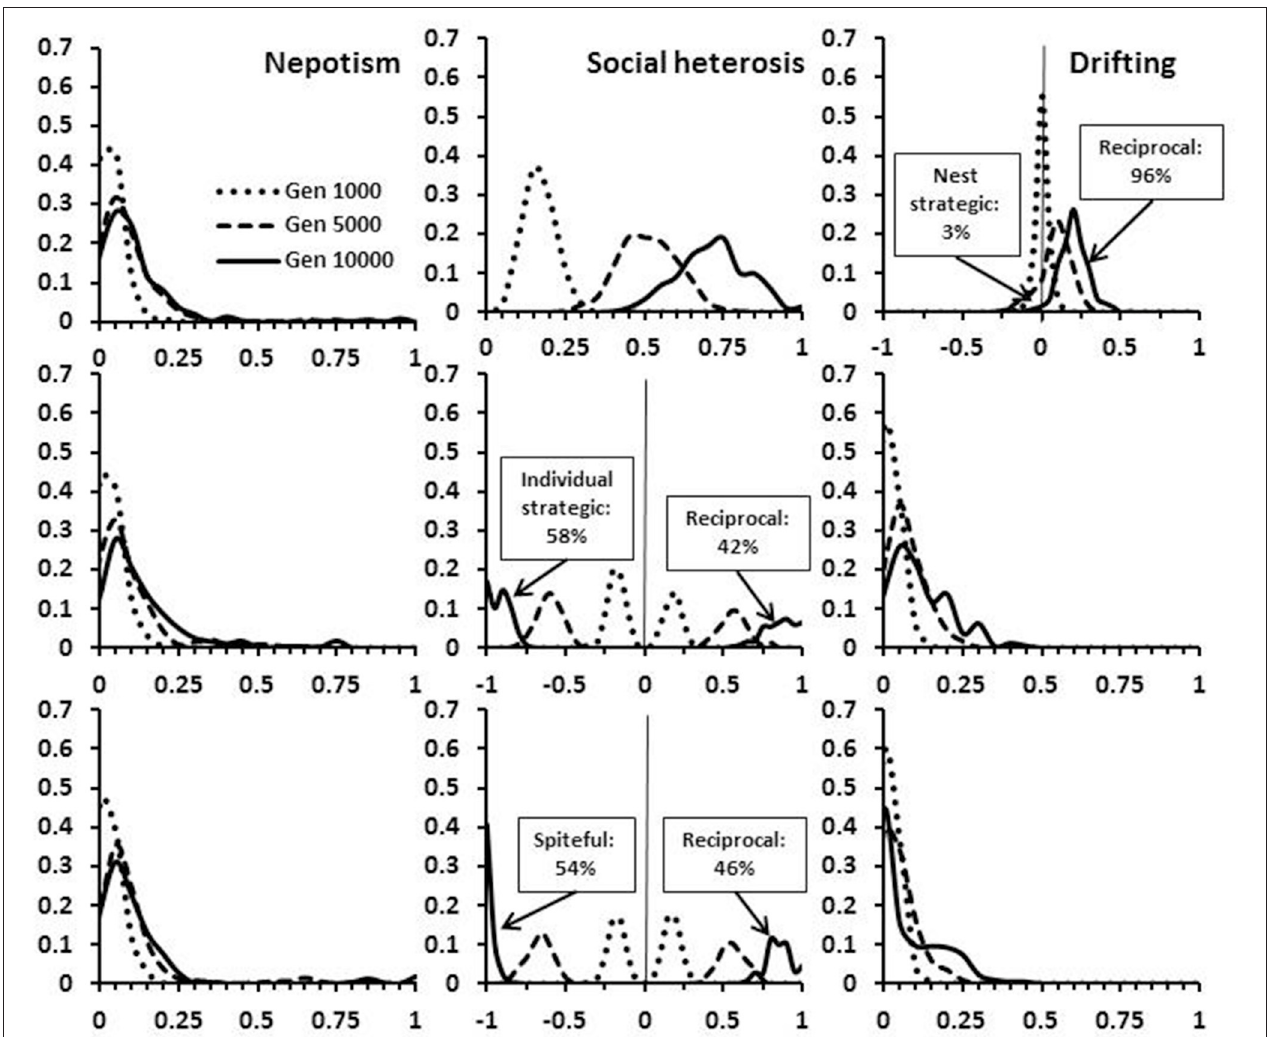
FIGURE 6 | Frequency of alleles at the expression loci for nepotism, social heterosis and drifting when cheating is possible. The distributions are given at time periods 1,000, 5,000, and 10,000 in the simulations, with h = 1.00. In the top panel cheating produces nests that differentially collect drifters. In the middle panel, individual drifters behave strategically and provide less social heterosis to non-natal nests. In the bottom panel, drifters act spitefully in non-natal nests. For demonstration purposes, reciprocating alleles are shown as positive values and cheating alleles as negative values (ranges 0 ±